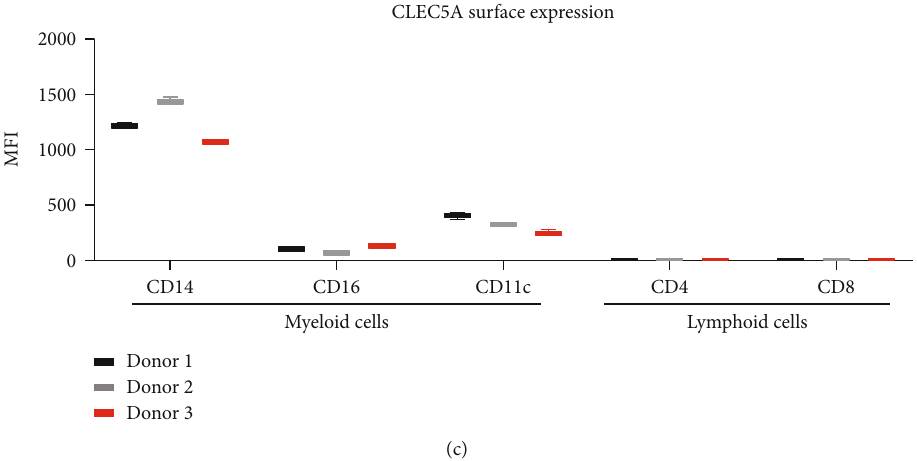
Figure 3: CLEC5A receptor is highly expressed on human myeloid cells. PBMC isolated from healthy donors were stained at 5 x 10 5 cells in 100 μ L/well with a FACS staining solution containing selected antibodies for myeloid and lymphoid cell surface markers: CLEC5A (1 :40), CD14 (1 :80), CD16 (1 :10), CD11c (1 :20), CD4 (1 :160), and CD8 (1 :20). CLEC5A expression was measured by fl ow cytometry. (a) CLEC5A expression (grey line) vs negative ctrl (grey shadow) on selected immune cell populations: myeloid cells (upper panel) and lymphoid cells (lower panel). Shown are exemplary histograms from one representative donor. (b) Frequency of CLEC5A-expressing cells (shown as percentage of CLEC5A-positive cells) in selected immune cell populations from 3 individual donors. (c) Median fl uorescence intensity (MFI) of CLEC5A expression in selected immune cell populations from 3 individual donors. Shown is one representative experiment from two independent measurements (six donors, three technical replicates per donor) with similar outcome.